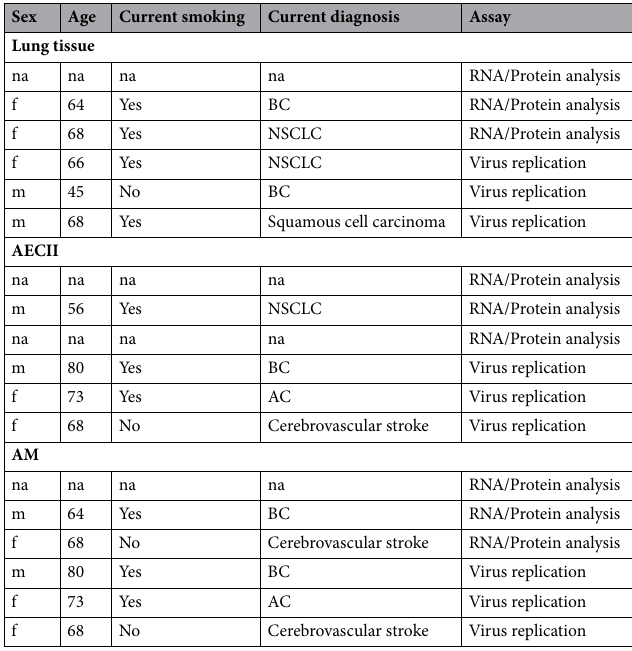
Table 1. Clinical patient data for used human lung tissue as far as known. Lung tissue used for infection was free of tumor and taken from unaffected areas which were histologically considered as “normal”. BC